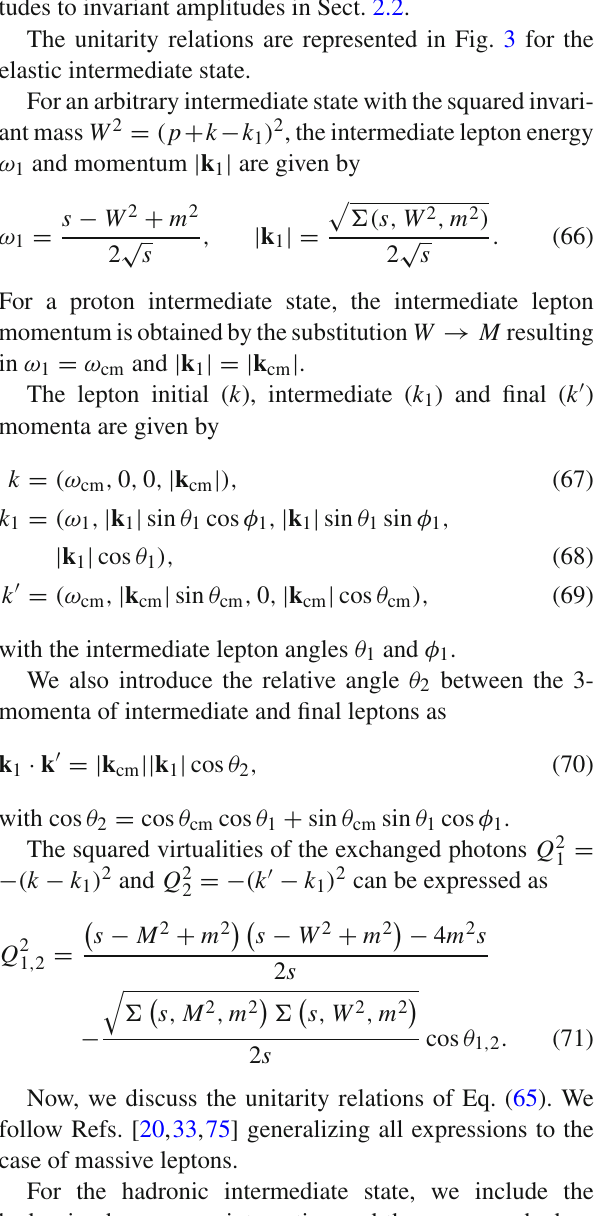
exploit this frame relating the lepton–proton helicity ampli- tudes to invariant amplitudes in Sect.